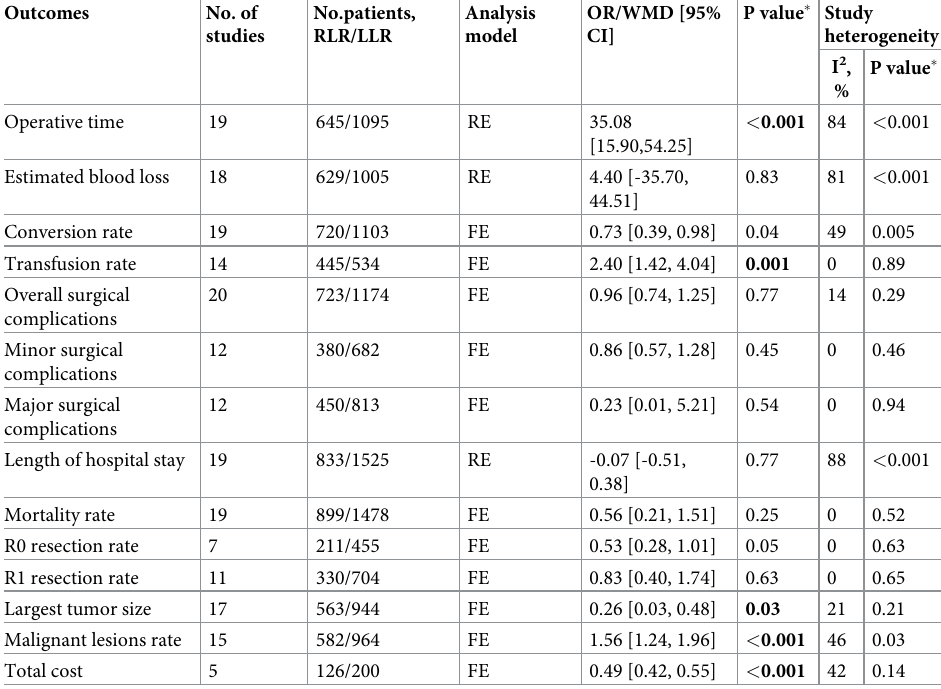
Table 4. Sensitivity analysis of retrospective non-matched comparative and retrospective matched comparative studies.